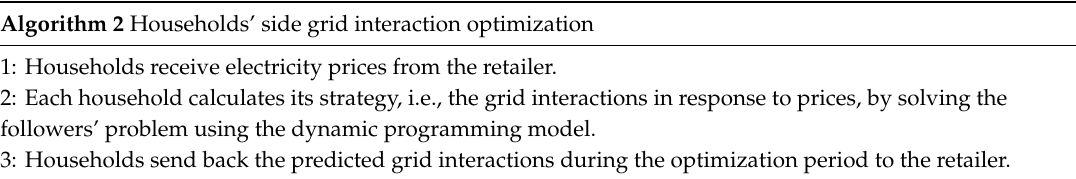
Algorithm 2 Households’ side grid interaction